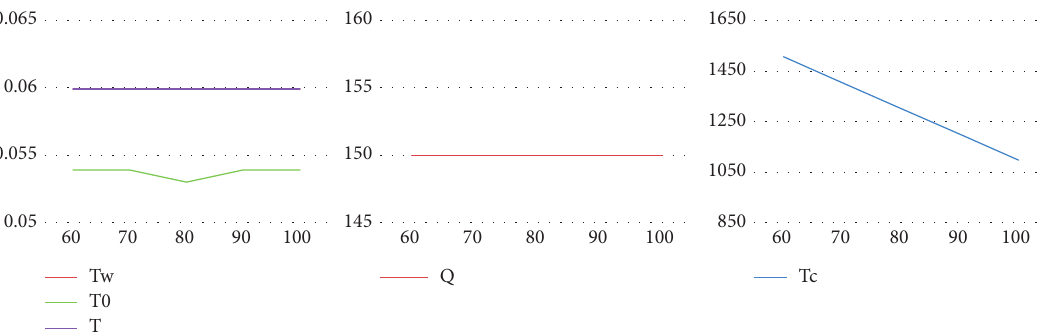
Figure 11: The effect of parameter p on decision variables.